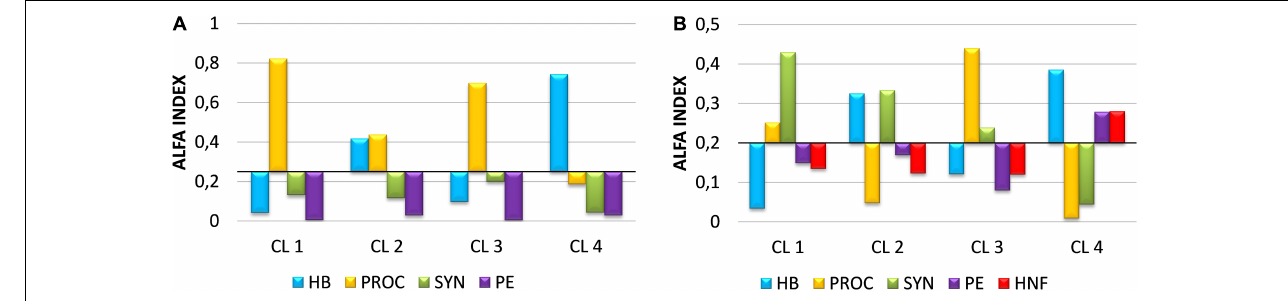
FIGURE 7 | Manly-Chesson normalized alpha index showing preference or prey selection for HNF (A) and ciliates (B) . HB, heterotrophic bacteria; PROC, Prochlorococcus; SYN, Synechococcus; PE, picoeukaryotes; HNF, heterotrophic nanoflagellates.